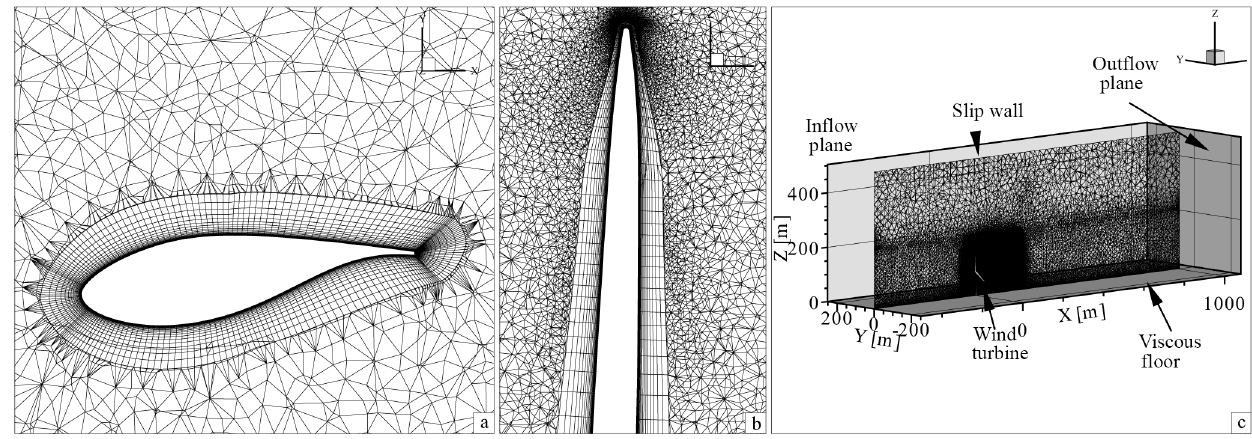
Figure 1. Computational grid set-up; (a) chord-wise distribution; (b) span-wise distribution in blade tip region; (c) cut through the flow field and boundary